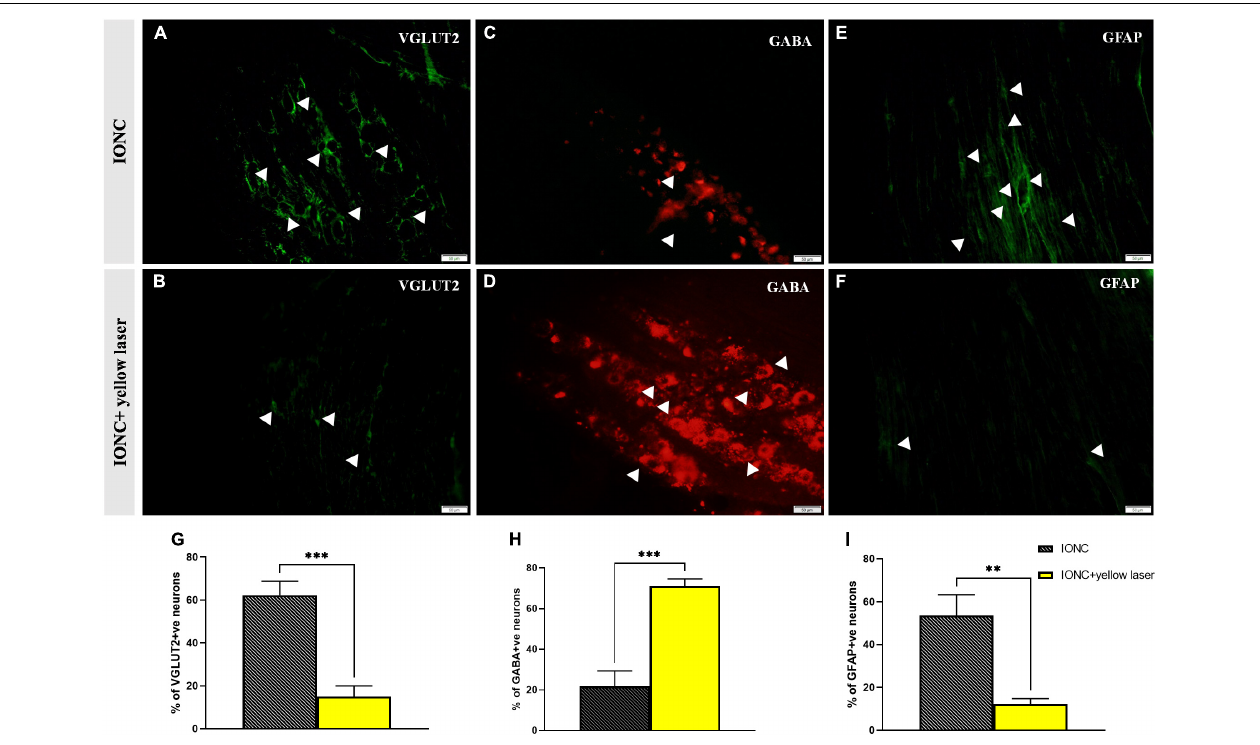
FIGURE 6 | VGLUT2, GABA and GFAP immunofluorescence expression in the trigeminal ganglion. (A) Increased VGLUT2 expression in IONC; shown with white arrows. (B) NpHR-mediated TG inhibition reduced VGLUT2 expression in the trigeminal ganglion, depicted with white arrows. (C) Reduced GABA expression in IONC rats, shown with white arrows. (D) Yellow laser stimulation in the TG resulted in increased GABA expression, as shown by white arrowheads. (E) Increased GFAP expression in IONCs, as shown by white arrows. (F) GFAP expression following yellow laser stimulation in the trigeminal ganglion; shown with white arrows. Scale = 50 µ m. (G) Quantification of VGLUT2 expression (expressed in percentage) in laser on and off conditions of injured animals. Significant alteration was observed in unpaired t -test ( ∗∗∗ p = 0.0005, n = 3). (H) GABA expression (given as a percentage) in injured animals under laser on and off circumstances. Significant alteration was observed in unpaired t -test ( ∗∗∗ p = 0.0005, n = 3). (I) Quantification of GFAP expression (given in percentage) in laser on and off conditions of injured animals. Significant alteration was observed in unpaired t -test ( ∗∗ p = 0.0020, n = 3). Data are presented as the mean ±